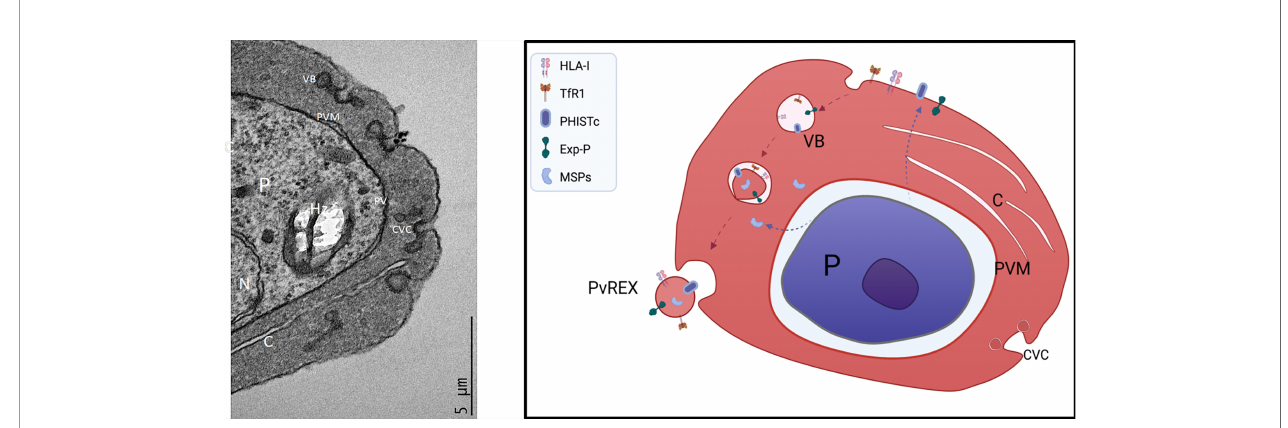
FIGURE 4 | Model of EV biogenesis in P. vivax -Infected reticulocytes. Left, transmission electron micrograph (TEM) image of a P. vivax -infected reticulocyte. P, parasite; N, nucleus; Hz, hemozooin crystal; PV, parasitophorous vacuole; PVM, parasitophorous vacuole membrane; VB, Vesicular body; C, Clefts; CVC, Caveola- Vesicle-Complex. Right. Model of EV biogenesis. Upon entrance to the reticulocyte, P. vivax remodels the cytoplasm, including the formation of clefts facilitating the export of variant proteins such as PHISTc and Plasmodium exported proteins to the reticulocyte membrane. Endocytosis of this membrane containing parasite proteins, the transferrin receptor (CD71), and other selected cargo (i.e. HLA-I), creates a single membrane cytoplasmic endosome. Upon re-invagination of this membrane and incorporation of soluble proteins found in the cytoplasm, electrodense double membrane vesicles are formed which upon fusion to CVC release CD71 + EVs. TEM image and model was made in biorender contributed by Carmen